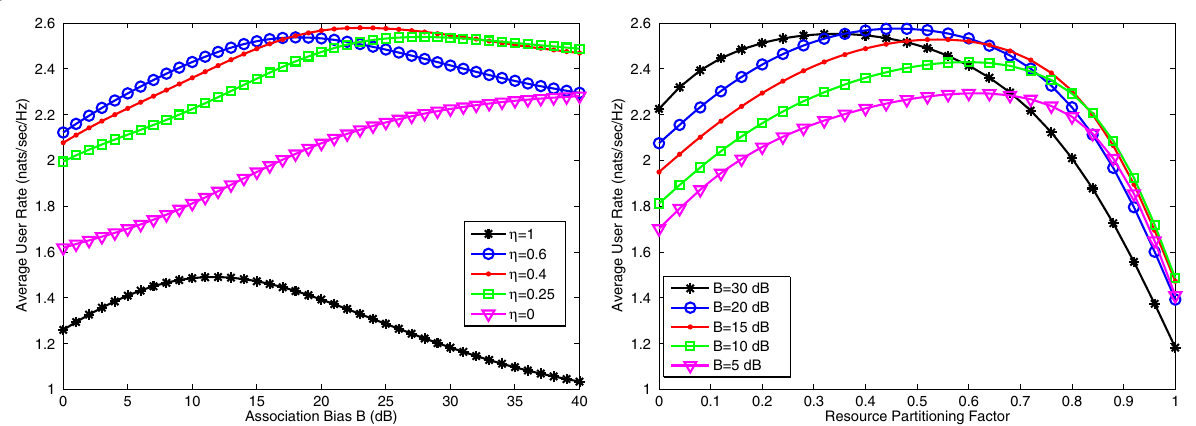
Fig. 9 Effect of association bias and resource partitioning factor on average user rate with β = 0.2, T FR,1 = − 20 dB, and T FR,2 = 4